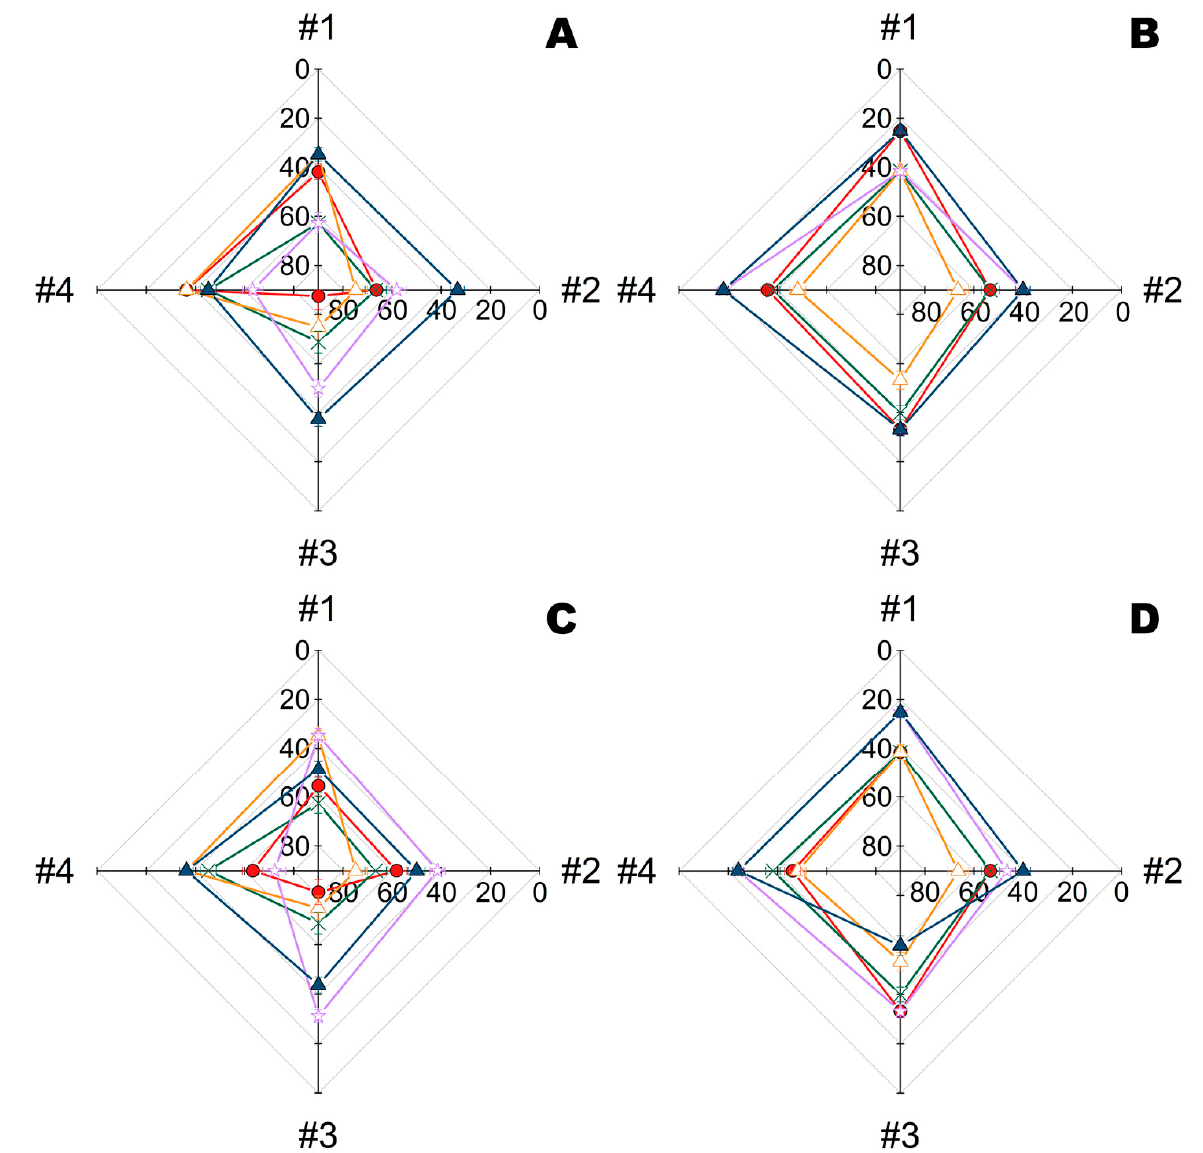
Figure 7. Residual intracellular ATP quantity (%) of B. subtilis ( A , C ) and E. coli bacterial cells ( B , D ) exposed for 24 h on multiple fiber materials (#1, #2, #3, and #4) treated with polymyxin B ( A , B ) or polymyxin E ( C , D ), enzymes (His 6 -OPH or PGA), or their combinations. ATP of bacterial cells similarly exposed on the same materials with treatment by buffer (i.e., controls) was taken as 100%.